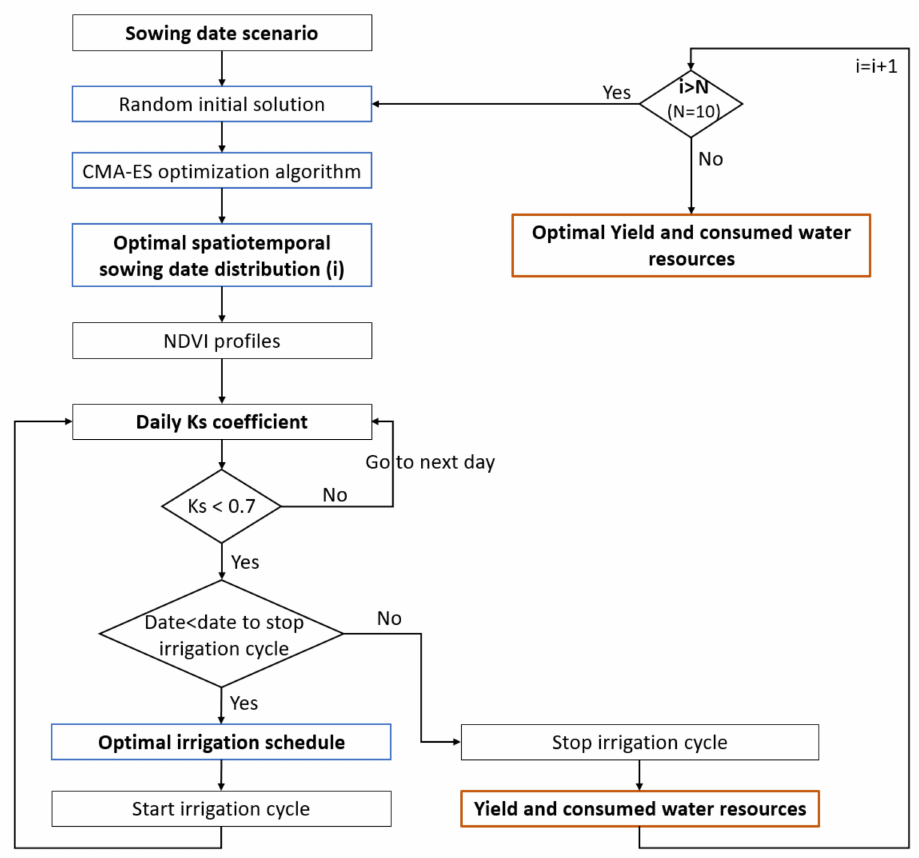
Figure 2. Flowchart of the proposed approach for yield and water resources optimization based on spatiotemporal sowing date